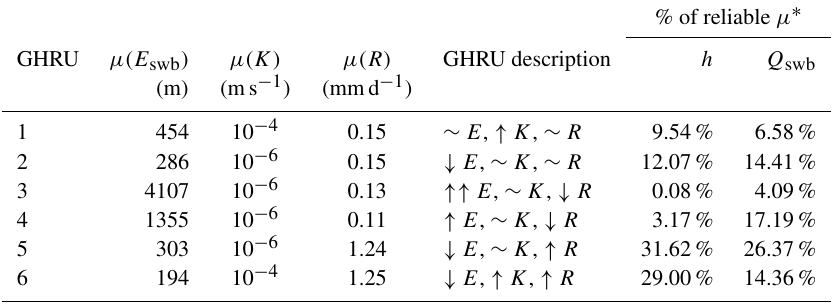
Table 2. Mean values of GHRU characteristics and their summarized description, where ↑ is read as a relatively high value, ∼ as medium, and ↓ as low; e.g., ↑↑ E indicates a cluster with very high and relatively high ( ↑ ) average E swb . Additionally, the last two columns show the percentage of cells per GHRU where µ ∗ of h and Q swb could be reliably determined (described in Sect. 3.2.6). % of reliable µ